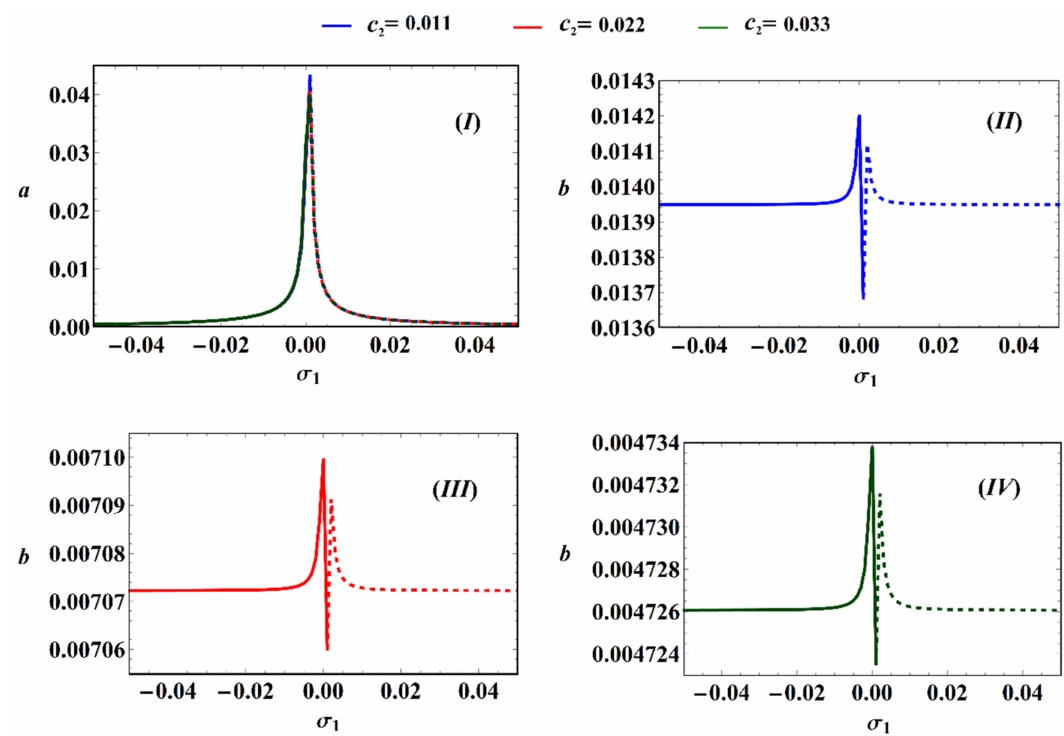
Figure 15. The frequency response at σ 2 = 0.001, W = 0.448, and c 1 = 0.001 for: a ( σ 1 ) as shown in ( I ), and b ( σ 1 ) as it is in ( II – IV ) when ( c 2 = 0.011, c 2 = 0.022, c 2 = 0.033 ).